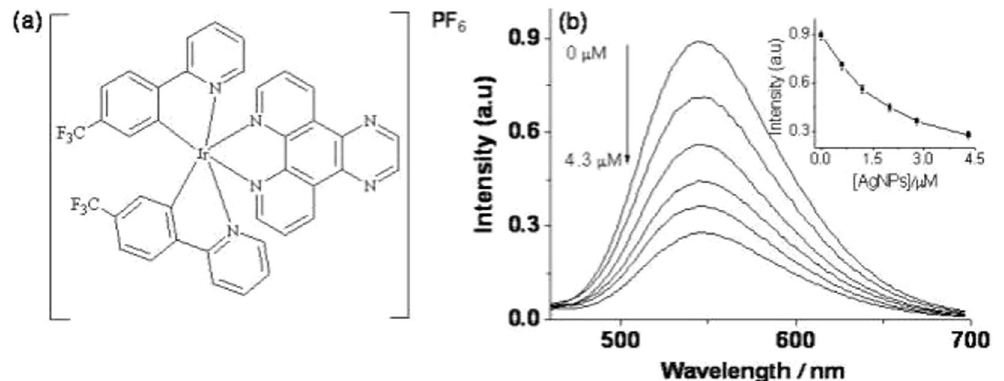
Figure 2. ( a ) Chemical structure of Ir-1 . ( b ) Luminescence emission spectra 0.3 μ M Ir-1 in Tris-HNO 3 buffer solution (pH 7.0) containing different concentrations of AgNPs. The inset is the luminescence intensity at 545 nm plotted against the AgNPs